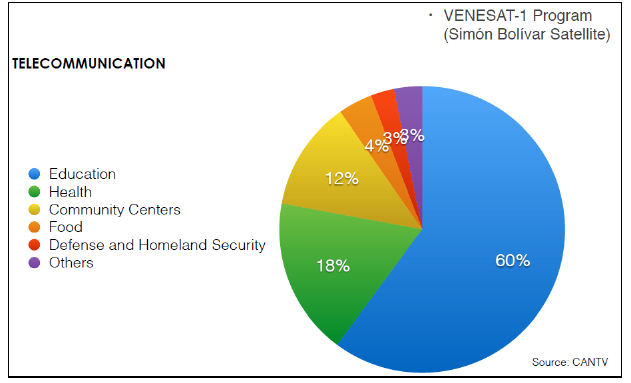
Figure N° 2: Space communication application in Venezuela. Source M. Imbert